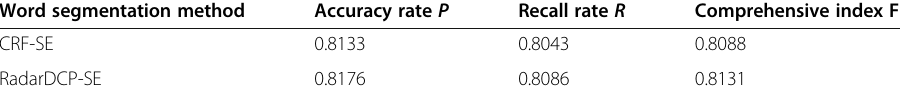
Table 3 Comparison results between CRF-SEand RadarDCP-SE on texts of common